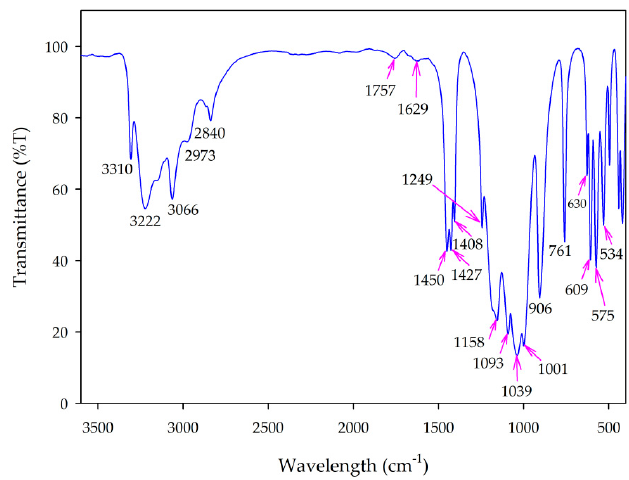
Figure 5. Fourier-transform infrared (FT-IR) spectrum of synthesized manganese violet.